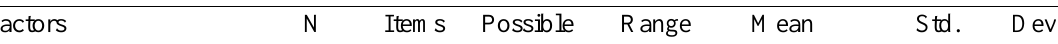
The Students’ Scores on the Subscales of the Web Attitude Scale Factors N Items Possible Range Mean Std.